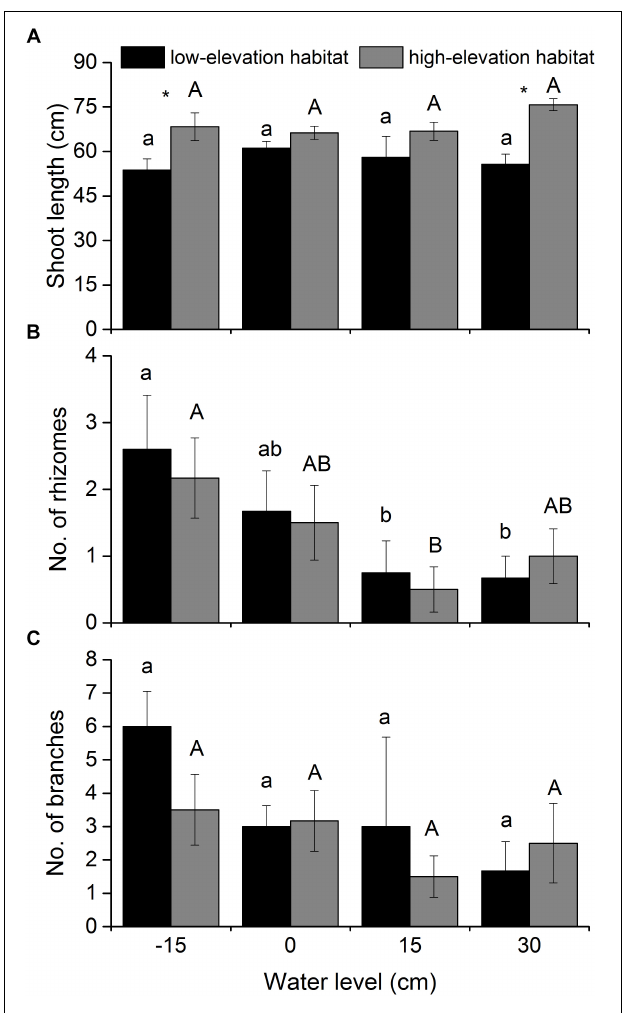
FIGURE 2 | Shoot length (A) , branch number (B) , and rhizome number (C) of P. hydropiper plants originating from two habitats grown under four water levels. Different lower-case or capital letters indicate that means differ significantly between the water level treatments for plants originating from low-elevation and high-elevation habitats, respectively. Symbols ( ∗ ) show which means differed between habitat types at each of the four water levels.